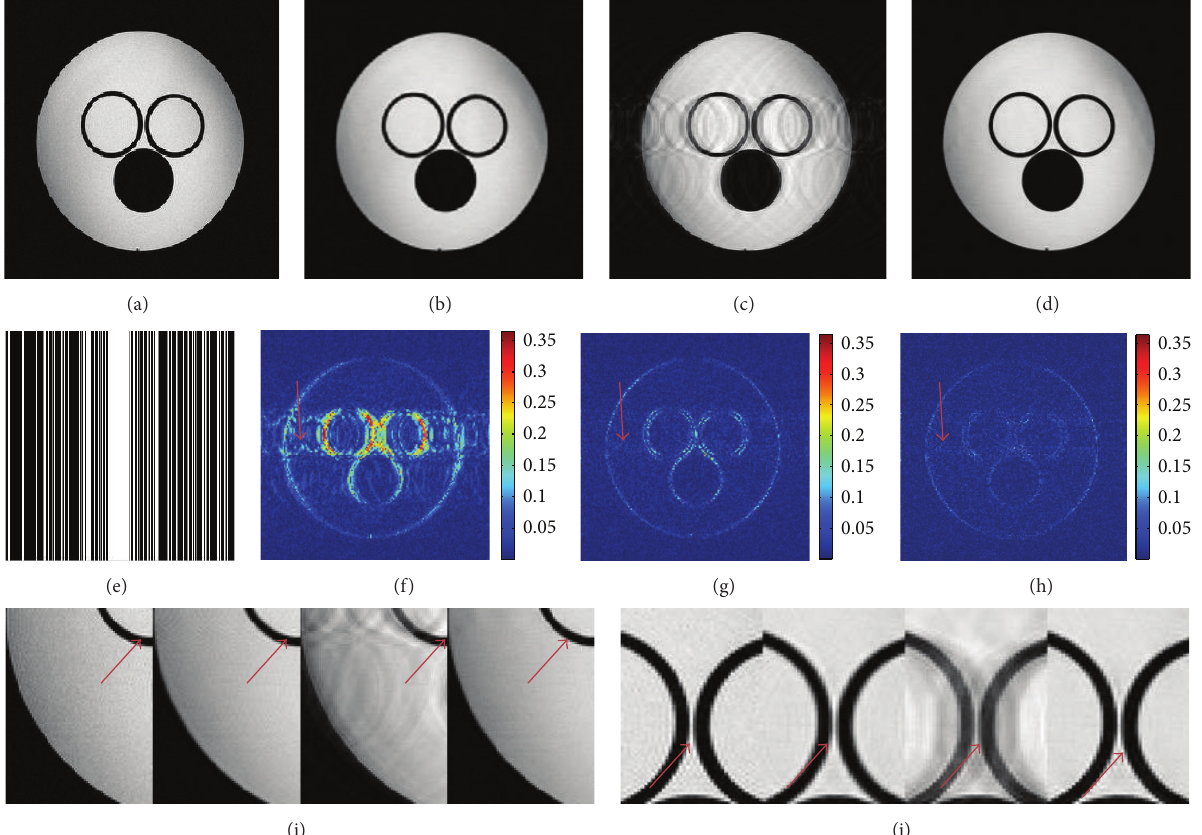
Figure 7: Reconstructed water phantom images at 35% undersampling. (a) The fully sampled image. ((b), (c), (d)) The reconstruction images corresponding to DLMRI, SHTGV, and DLTGV. (e) Mask data with 35% Cartesian sampling. ((f), (g), (h)) Reconstruction error magnitudes for DLMRI, SHTGV, and DLTGV. ((i), (j)) Enlargements of (a), (b), (c), and